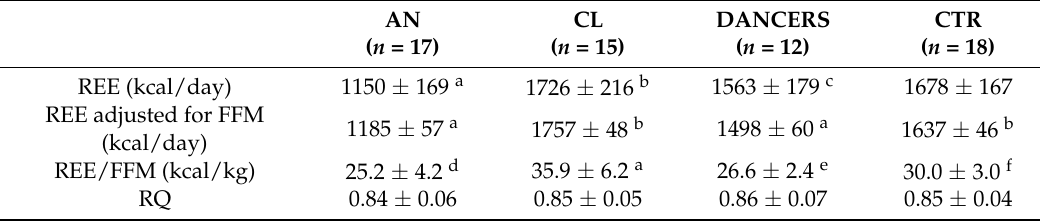
Table 3. Resting energy expenditure of 62 males individuals, according to leanness groups.